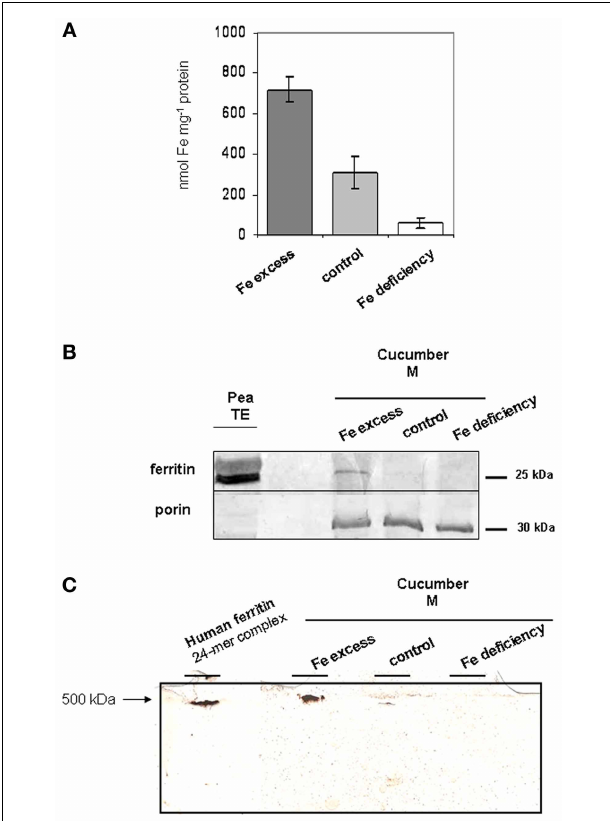
FIGURE 4 | Fe and ferritin content in mitochondria from cucumber roots grown under different conditions of Fe supply. (A) Total Fe content in mitochondria purified from Fe-excess, control, or Fe-deficiency roots, quantified by ICP-MS. Each bar represents the mean value ± SE from 4 independent samples consisting of 60–200 µ g mitochondria each. (B) SDS-PAGE and western blot analysis of mitochondria purified from Fe-excess, control, or Fe-deficiencyroot. 15 µ g proteins were loaded in each lane. As positive control, 34 µ g total extract (TE) from pea seeds, rich in ferritin, has been loaded in leftmost lane. (C) native PAGE analysis, followed by Prussian blue/DAB stain of mitochondria purified from Fe-excess, control or Fe-deficiencyroot; 40 µ g proteins were loaded in each lane. As positive control, 48 µ g proteins recombinant human ferritin consisting of a 24-mer of around 500KDa, was also loaded in the far left lane. XP_004148174 (annotated at NCBI as ferritin-3, chloroplast-like) ( Figure S2 ) five different primers Cucsafor1, Cucsarev1-rev4 were designed for RT-PCR experiments with RNA purified from either roots or leaves from Fe-excess cucumber plants (thus accumu- lating ferritin). Results show that RT-PCR with the following pairs: Cucsafor1-Cucsarev1 and Cucsafor1-Cucsarev2, amplified, respectively a fragment of 436 and 470 bp ( Figure 5B , left panel), as expected from an mRNA coding for XP004163524 ( Figure 5A ) but not from an mRNA coding for XP004163525 ( Figure S1 ).